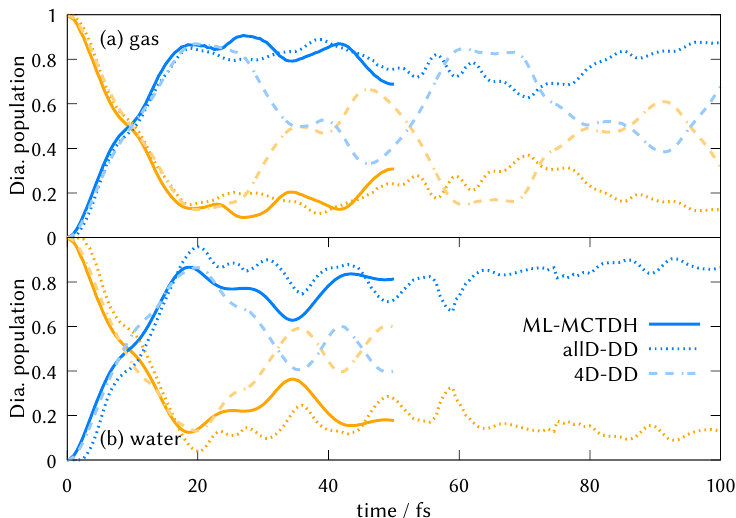
Figure 7. Comparison of the ( a ) gas phase and ( b ) water cluster time evolution of the diabatic popula- tions when running direct dynamics in full dimensionality (dotted line), in four dimensions (dashed line) corresponding to the most important normal modes (see Figure S4) and in the parametrised LVC potentials in full dimensionality with the ML-MCTDH method (solid